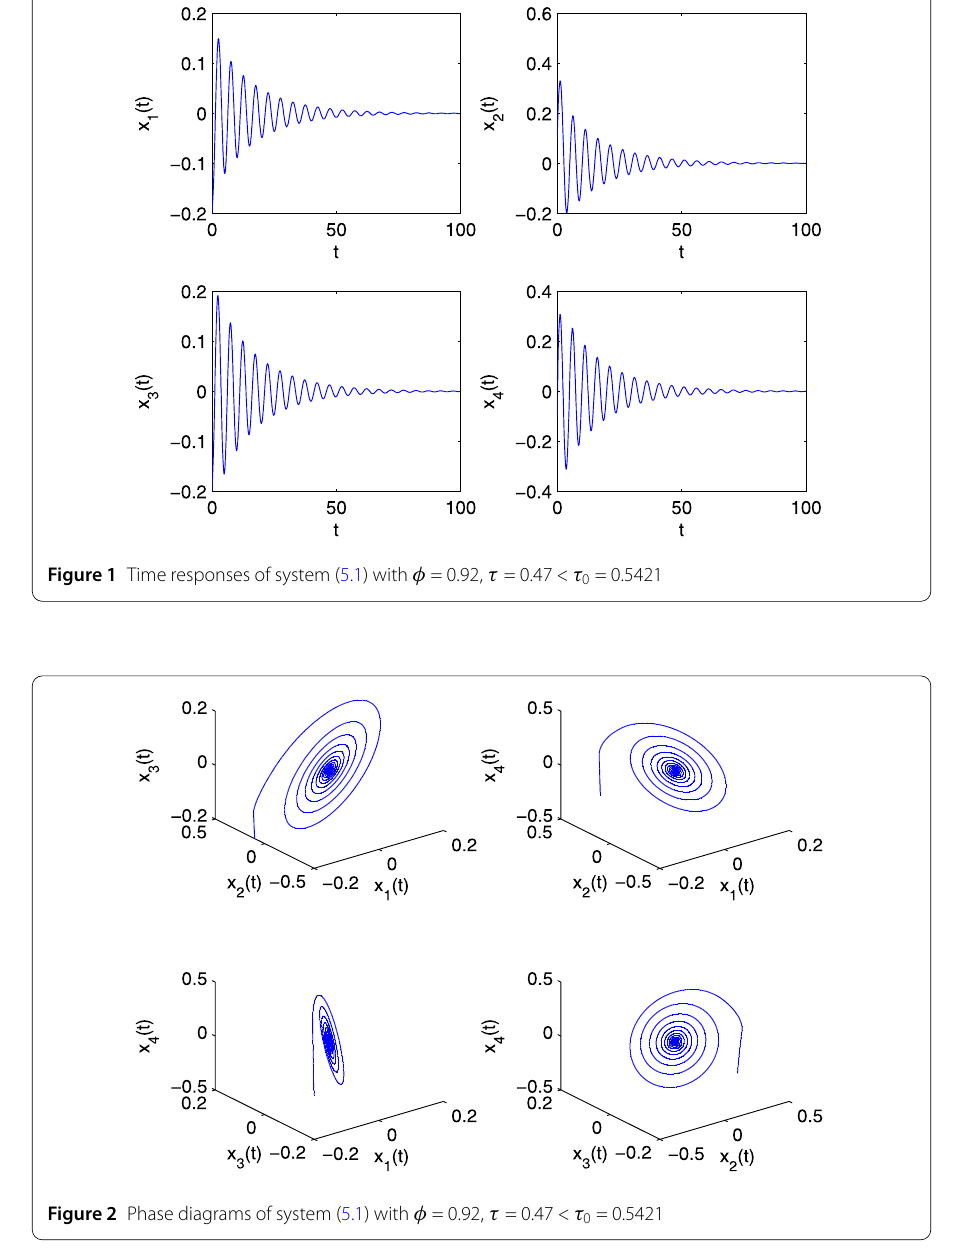
(ii) system (3.2) undergoes a Hopf bifurcation at the origin when τ = τ ∗ one branch of periodic solutions bifurcating from the zero equilibrium point near τ = τ ∗ 0